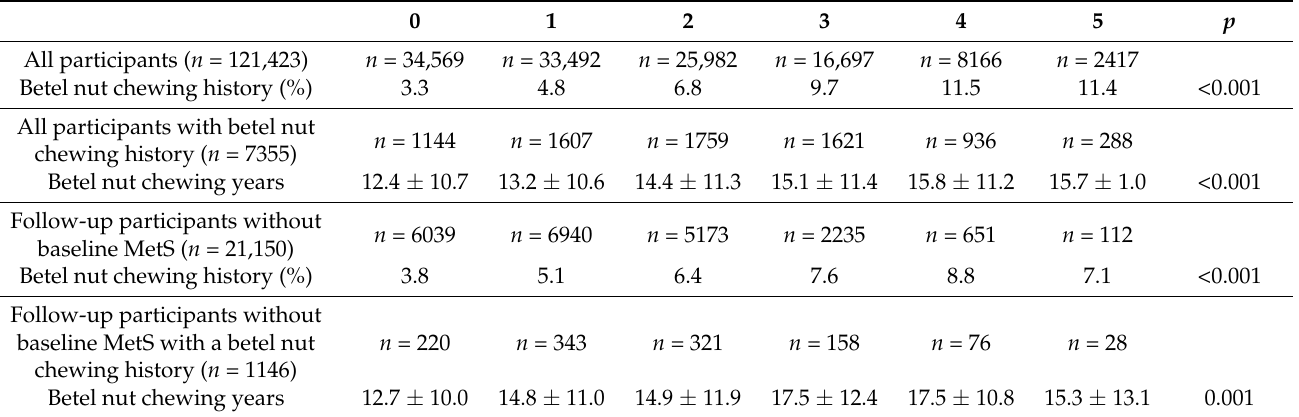
Table 6. Prevalence of betel nut chewing history and betel nut chewing years according to the sum of components of